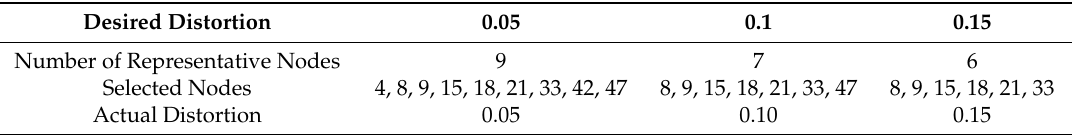
Table 9. Selection of representative nodes and the actual distortion based on a practical calculation (dataset 1 with N = 11 nodes).